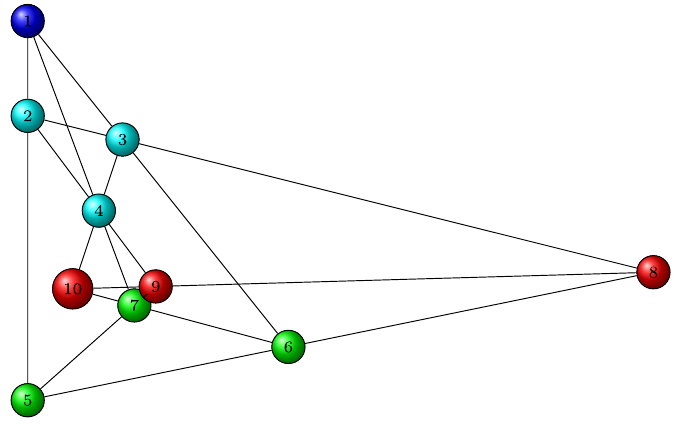
Figure 1. A simple graph X